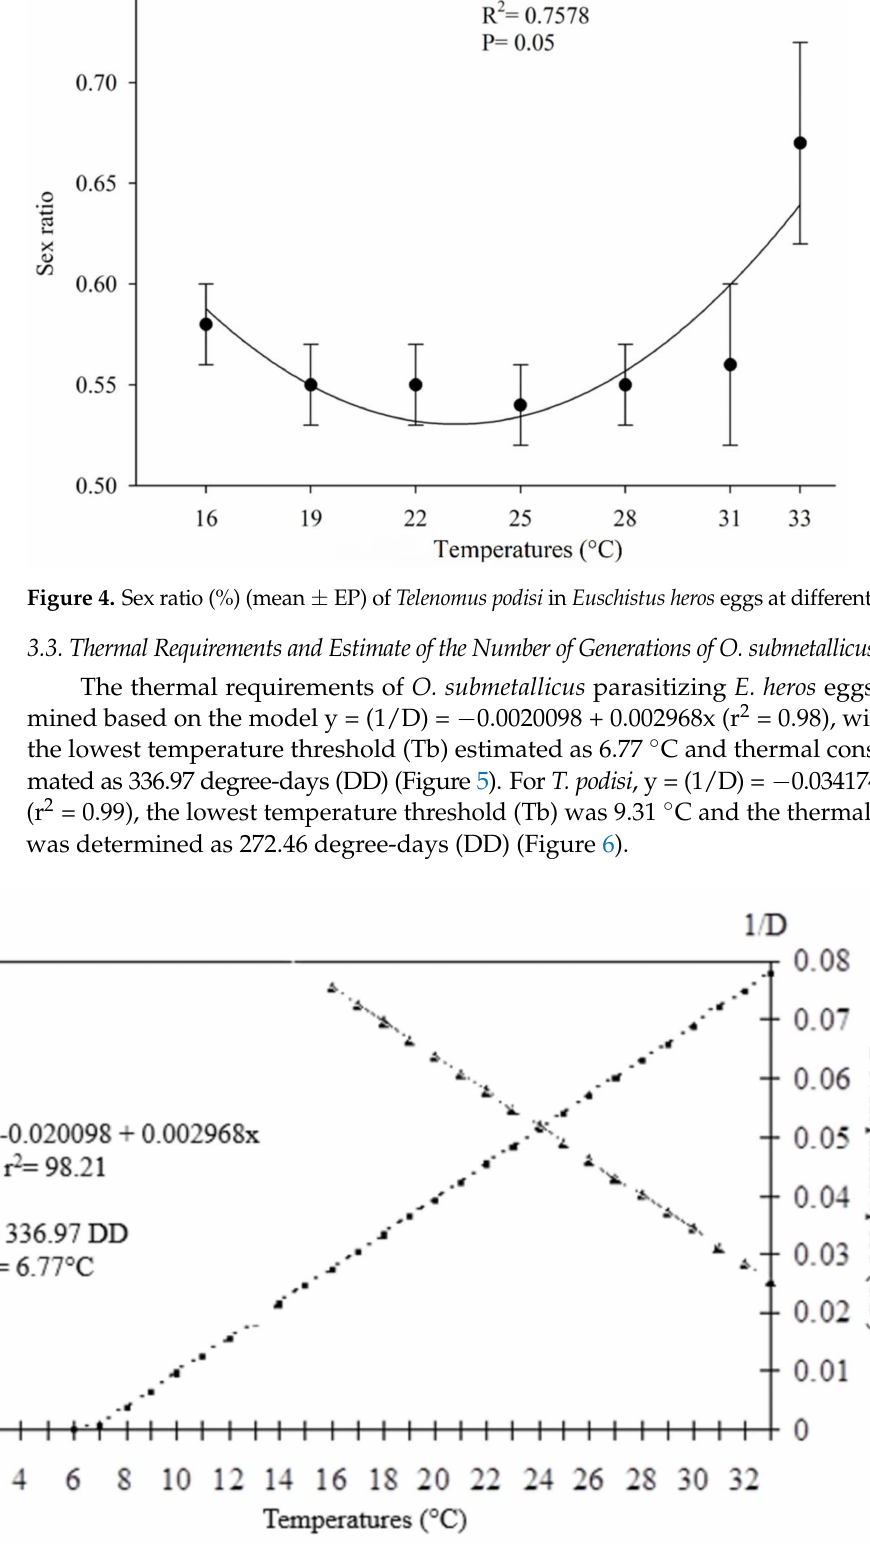
Figure 5. Duration (days) and developmental speed of Ooencyrtus submetallicus in eggs of Euschistus heros at different temperatures. K: thermal constant; Tb: base